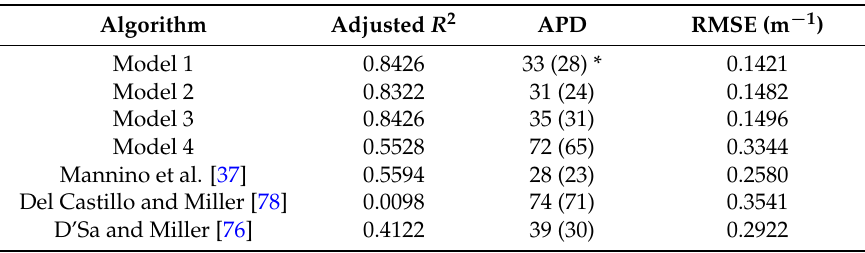
Table 8. Comparison results of the prediction ability of the four models on the validation data set. Three additional models taken from bibliography are also